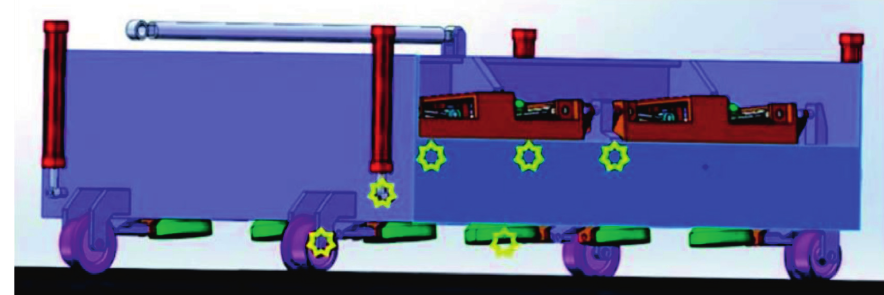
Figure 16: Excited points for different components of rail grinder.